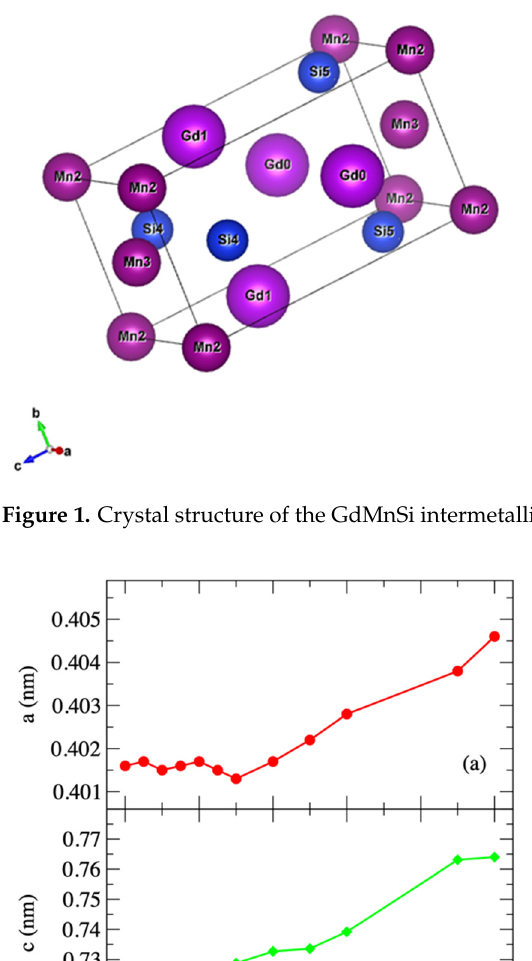
Figure 1. Crystal structure of the GdMnSi intermetallic compound, plotted with VESTA [21].